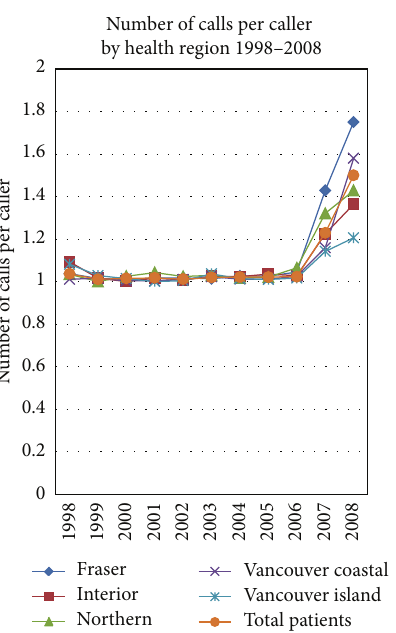
Figure 2: Number of calls per caller by health region, 1998– 2008. The POS service initially provided chiefly information and referral consistent with a single call per caller, serving both health professionals and women seeking care. From 2006 to 2008 there was an increasing trend toward “case management” where the complex needs of women seeking options for a second trimester pregnancy were handled by the service utilizing a series of calls with each individual.